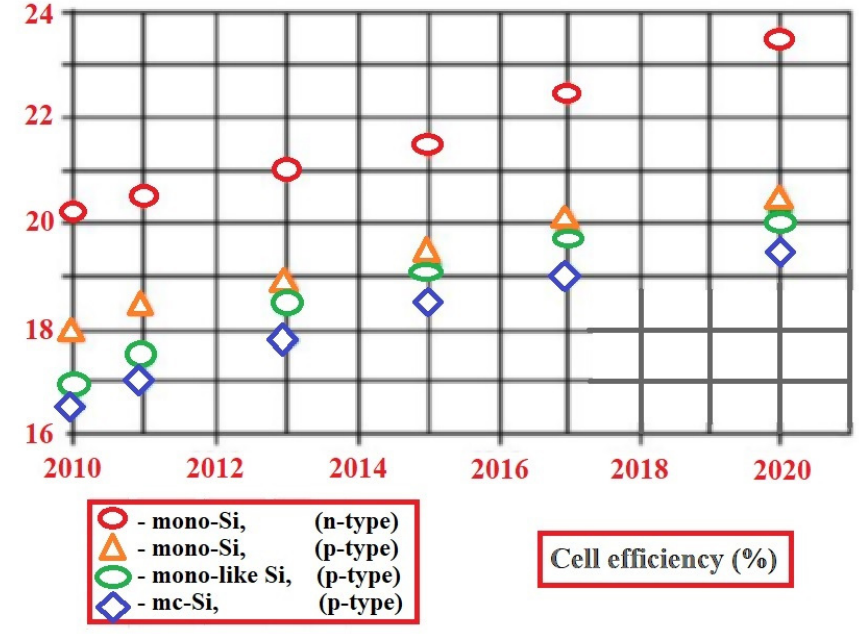
Figure 17. Stabilized cell efficiency trend curves [72].